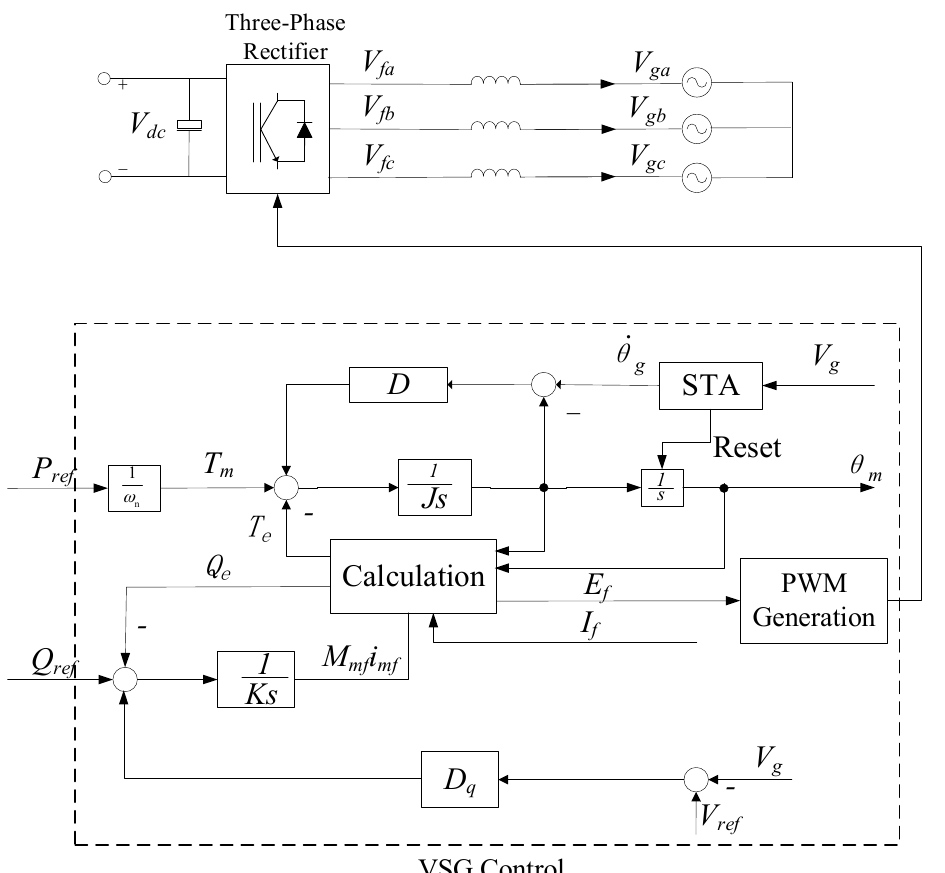
. θ  g ,  , the base frequency of the grid; P n ref